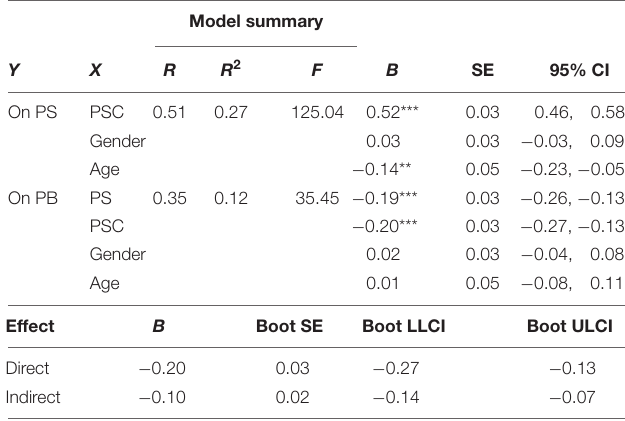
TABLE 2 | Summary of mediation